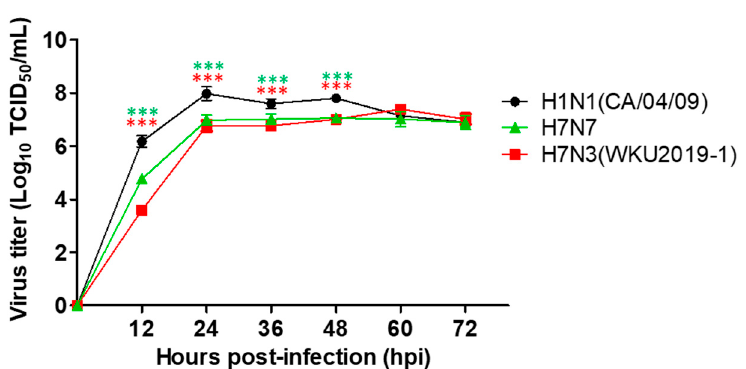
Figure 4. The virus growth kinetics of H7N3 (WKU2019-1) isolate in MDCK cells. MDCK cells were infected at an MOI of 0.01. The cell culture supernatant was harvested at different time-points (12, 24, 36, 48, 60, 72, and 84 h) after infection. The virus titer in cell culture supernatant was determined by an enzyme-linked immunosorbent assay (ELISA) using anti-influenza nucleoprotein to detect infected cells, and TCID 50 was determined in MDCK cells. The data are represented as mean ± SD and calculated from three repeats, *** p < 0.001.